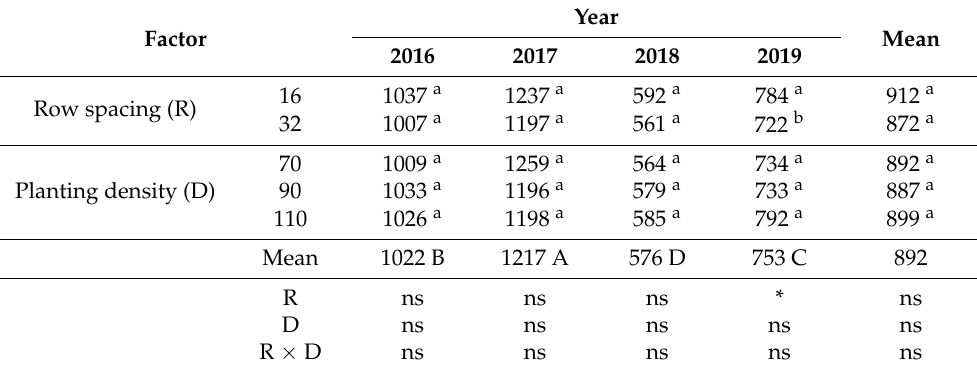
Values of a parameter followed by the same small letter in columns and big ones in rows did not differ significantly (ANOVA followed by Tukey’s HDS test, p < 0.01 and 0.05). ANOVA results: * p